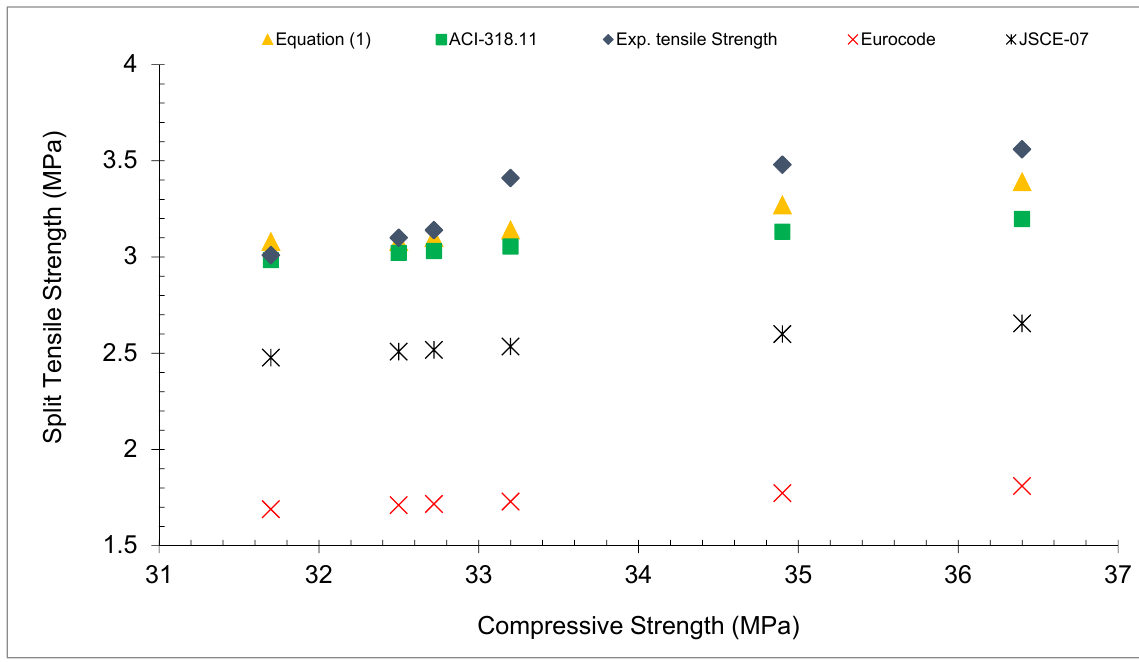
Figure 8. Correlation between compressive strength and split tensile strength.